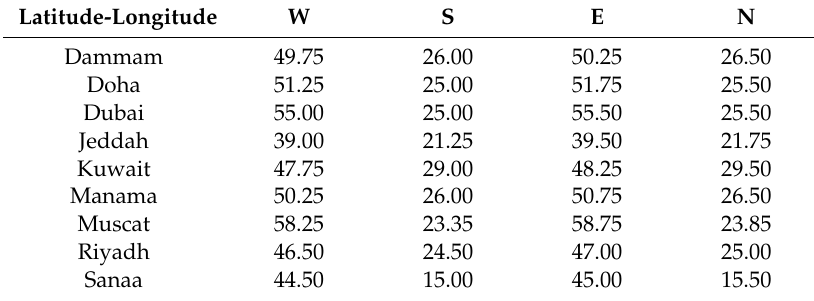
Table 1. Latitude and longitude used to retrieve modern-era retrospective analysis for research and applications (MERRA-2) aerosol optical thickness (AOT)